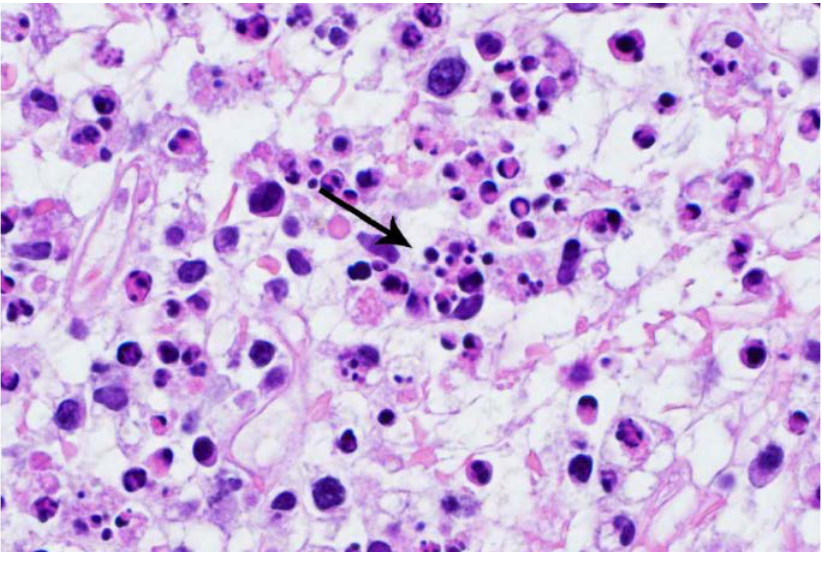
Figure 1. Bone marrow aspirate showing phagocytosis of neutrophils, erythrocytes, and platelets by hemophagocyte (black arrow). H&E